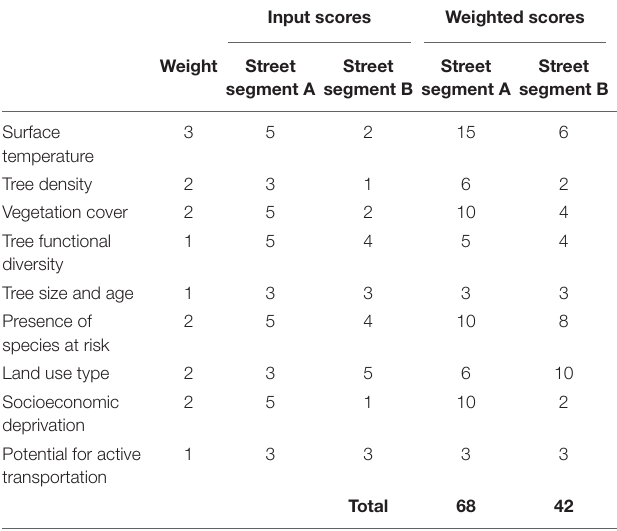
TABLE 1 | Input scores and weighted scores for the nine indicators used for prioritizing tree plantings in the City of Joliette for two street segments, one with very high priority (A) and one with very low priority (B), both highlighted in Figure 3